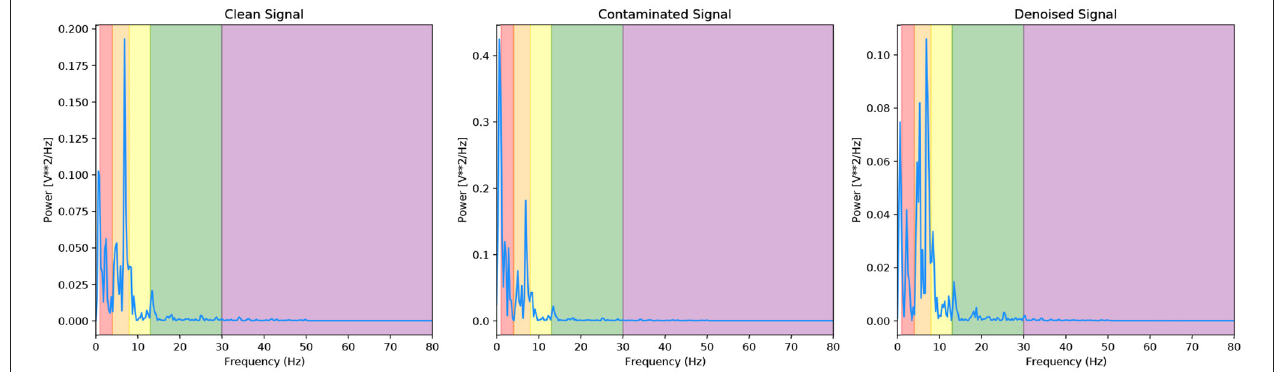
FIGURE 8 | PSD of the EEG-EOG signals shown in Figure 5 (left) with corresponding EEG bands.